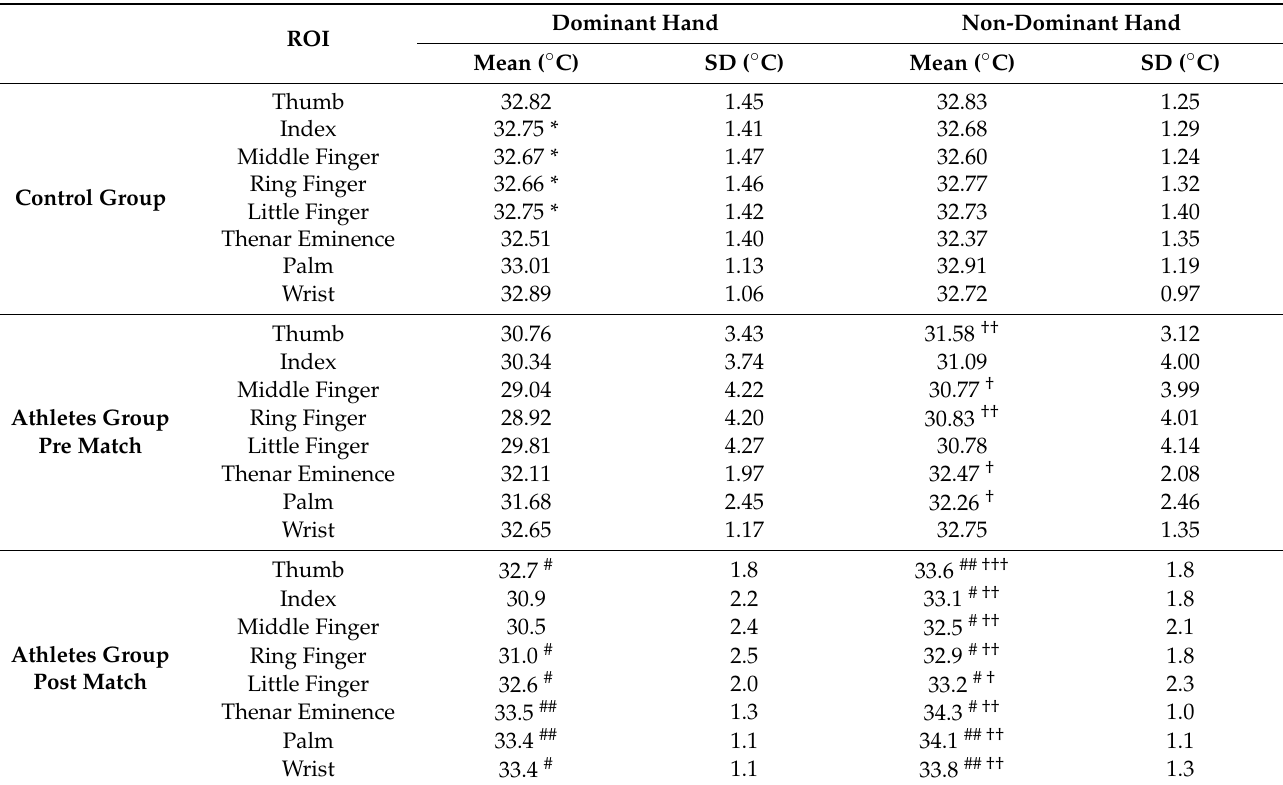
Table 2. Absolute values of skin temperature in dominant and non-dominant hands of all the groups. Figure 2. Regions of interest determined. ( 1 ) Thumb; ( 2 ) Index finger; ( 3 ) Middle finger; ( 4 ) Ring finger; ( 5 ) Little finger; ( 6 ) Thenar eminence; ( 7 ) Palm without thenar eminence; ( 8 ) Wrist.